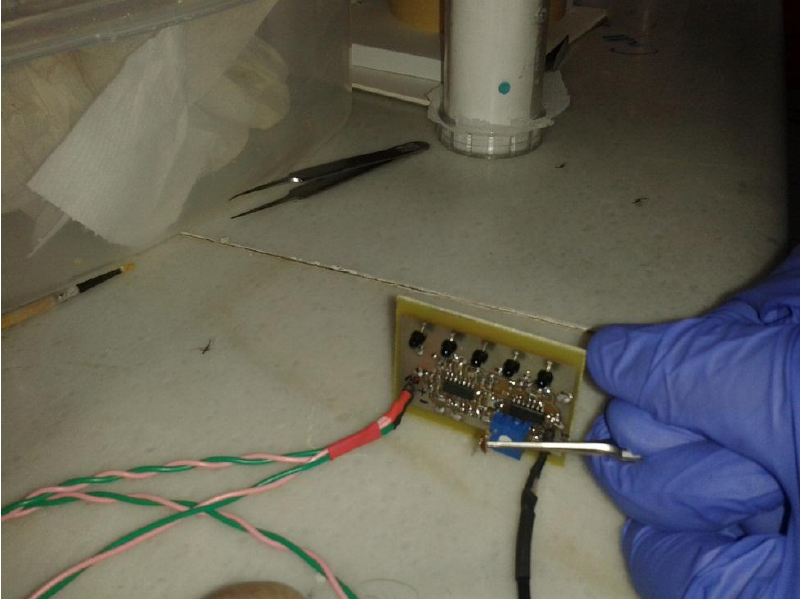
Figure 7. Wing-beat of an olive fly recorded with the optoelectronic